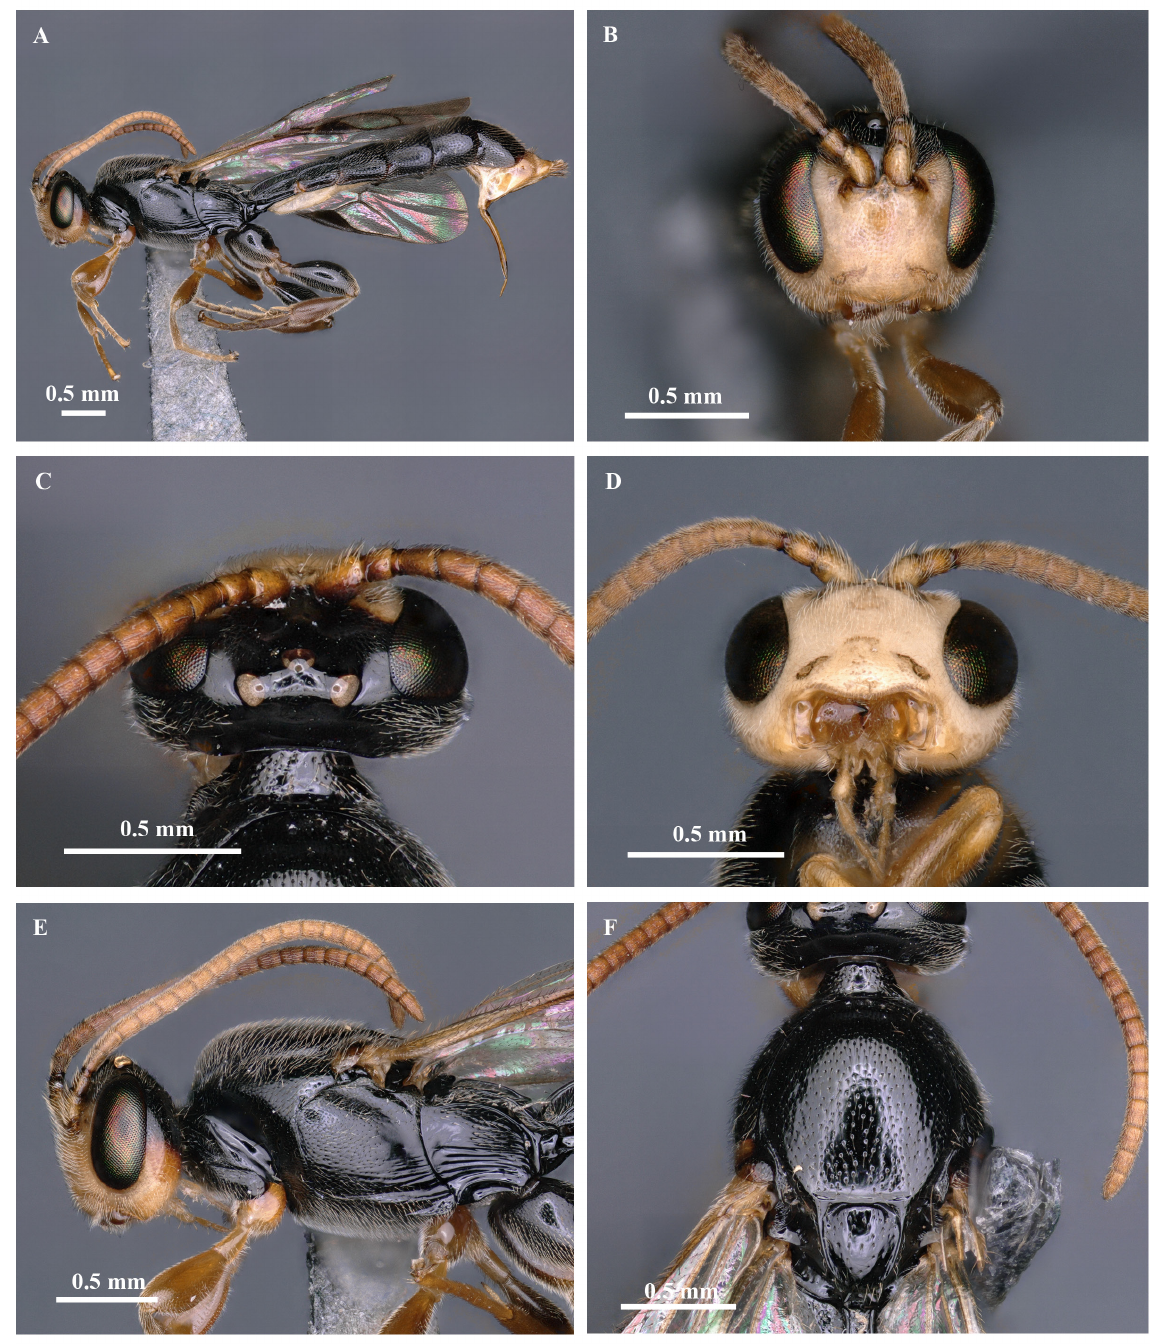
Fig. 1. Trieces irwini sp. nov., holotype, ♀ (AIMB). A . Habitus, lateral view. B . Head, anterior view. C . Head, dorsal view. D . Head, ventral view. E . Head and mesosoma, lateral view. F . Mesosoma, dorsal